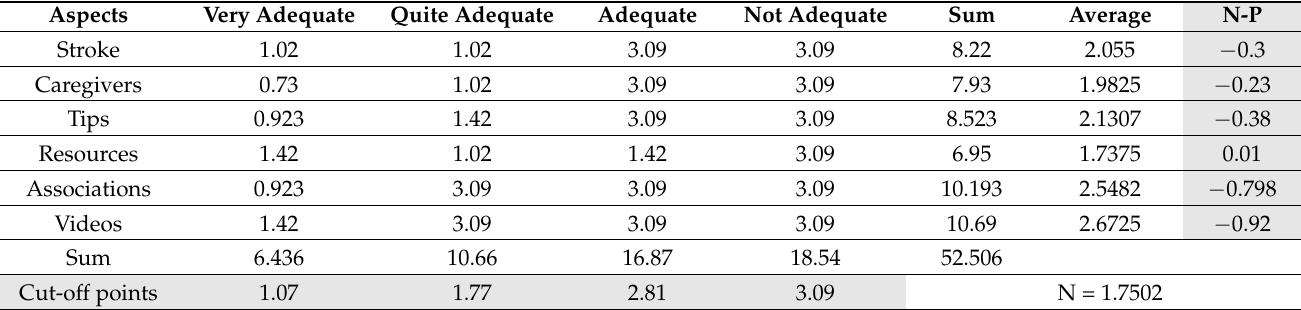
Table 4. Results obtained for the validation of the information by the Expert Consultation method (first